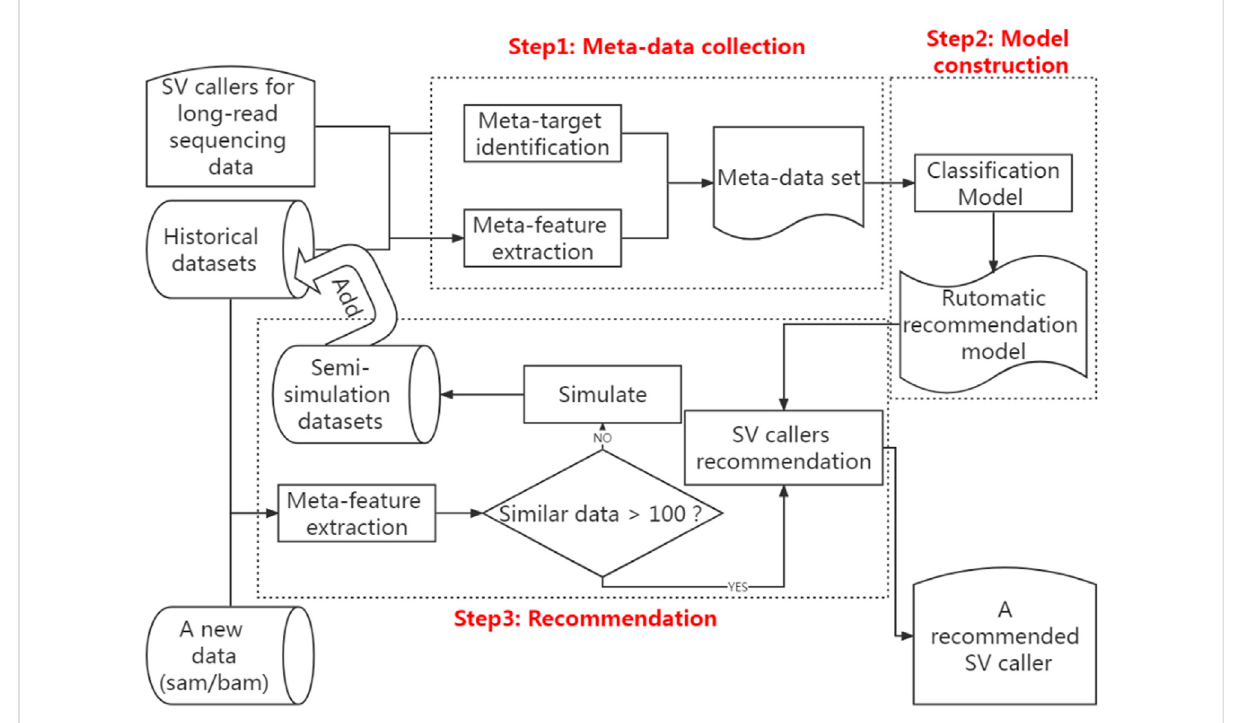
FIGURE 2 Computational pipeline for automatically recommending the optimal SV caller according to the features of sequencing